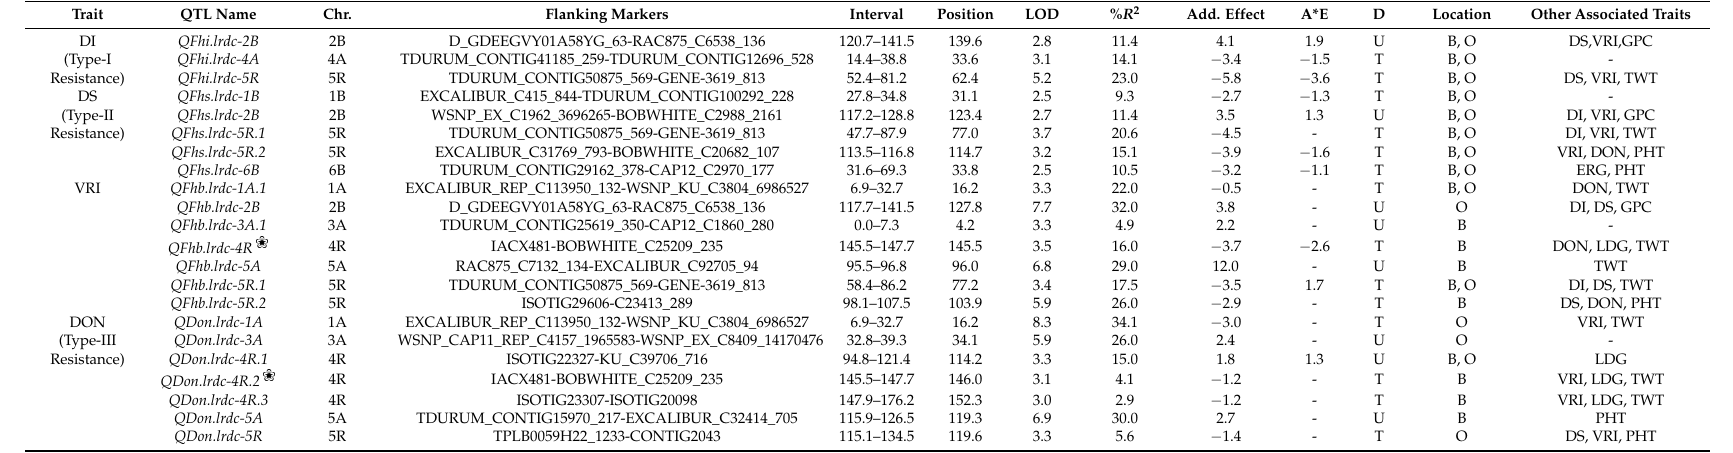
Table 4. Summary of FHB resistance related main effect QTL identified during the present study.